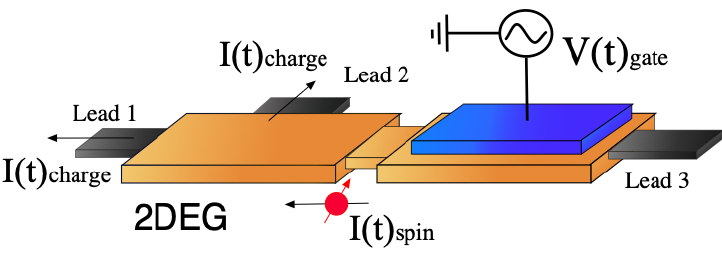
Figure 1: Sketch of the dynamical spin transistor. The on / off state of the spin tran- sistor is controlled by pinching off Lead 2 using a (side) gate. A time-dependent top gate voltage generates a pure spin current in the right part of the device and injects it through the middle bridge. 1 This spin current is converted to a nonzero charge current on the left part in the multiterminal system via a spatially inhomoge- neous Rashba interaction. Owing to the hidden Onsager relations, in a two-terminal system, the spin to charge conversion vanishes to leading order in the spin orbit cou- pling. This is the off-state of the transistor, which is achieved by pinching off the 2nd lead. The spin / charge conversion, hence the charge current out of the lead 1, is turned on by opening the second lead. This is the on-state of the